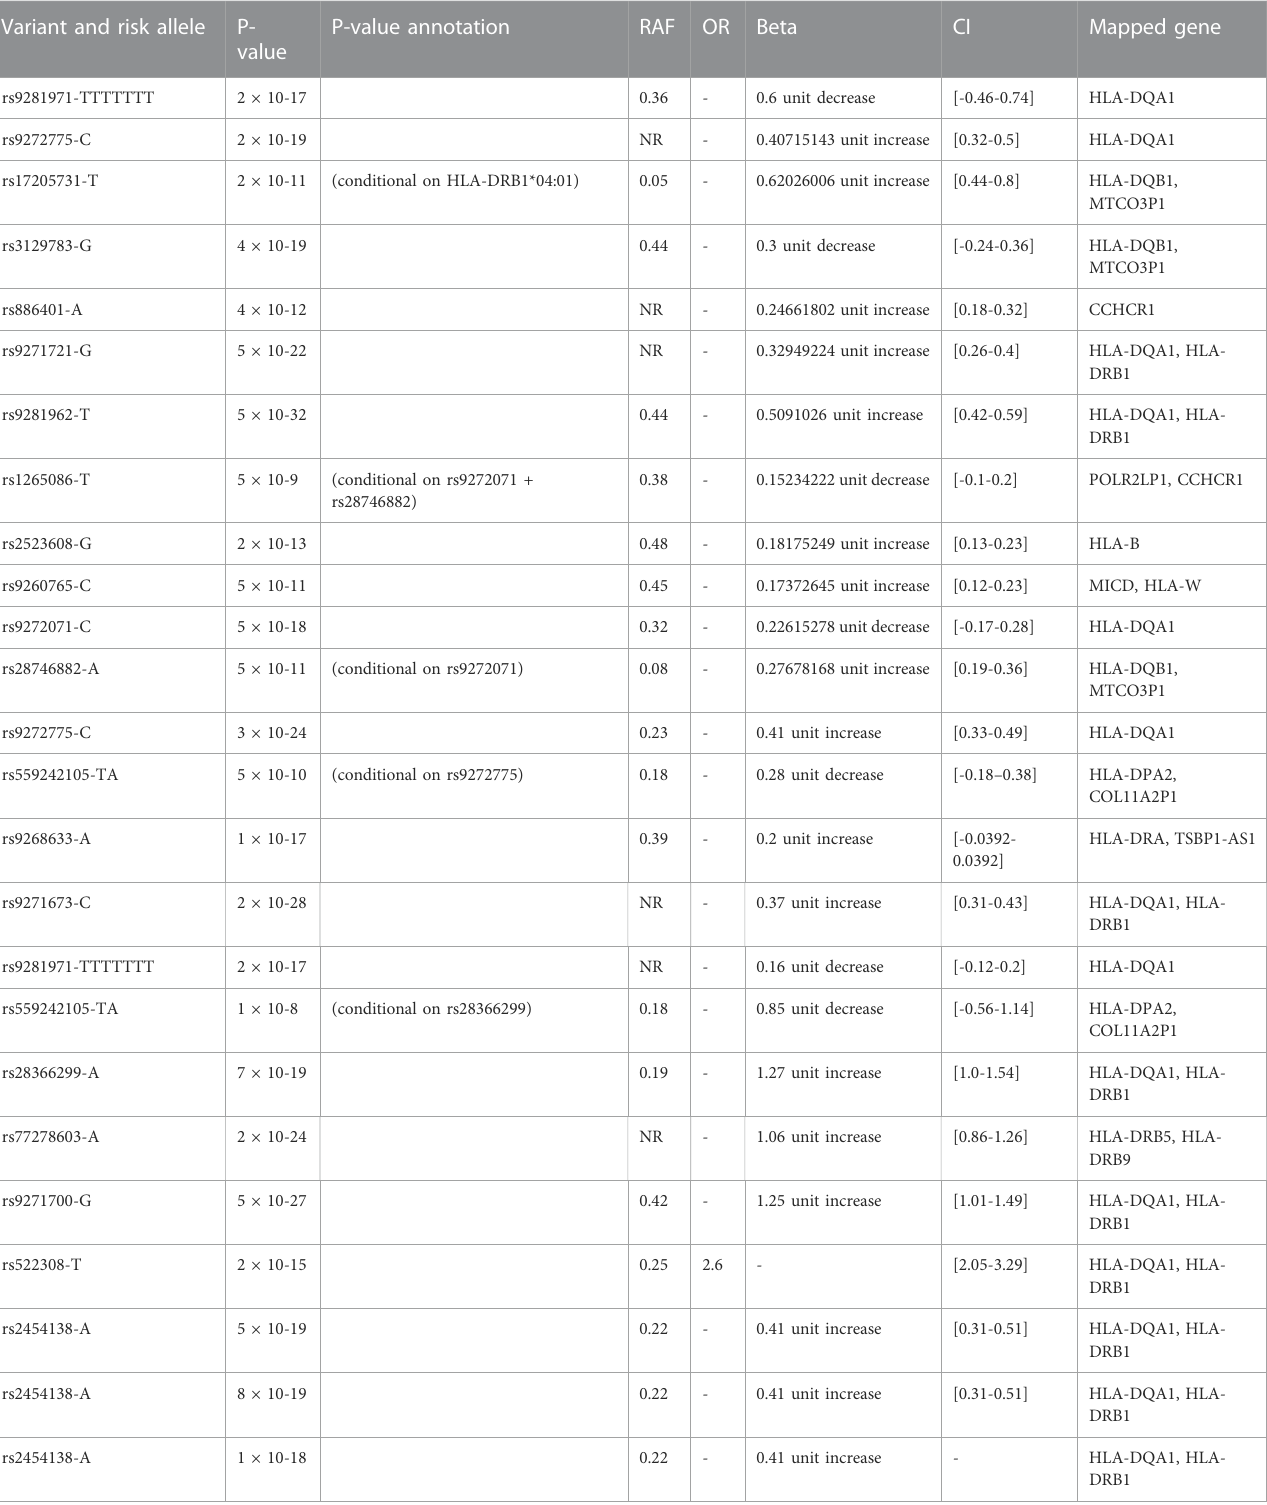
TABLE 1 Genetic variant and allele risk for response to interferon beta and anti-drug antibody measurement traits in multiple sclerosis from the Andlauer TFM Study (Andlauer TFM et al., 2020) Variant and risk